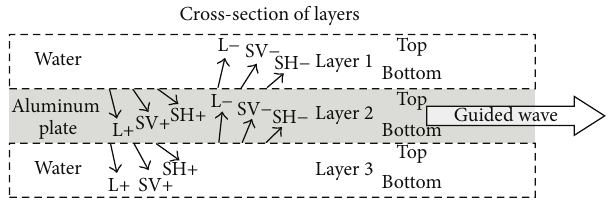
Figure 1: Geometry of a three-layer flat plate system showing the partial waves in each layer (L +− , SV +− , and SH +− ) that combine to produce a guided wave [7].